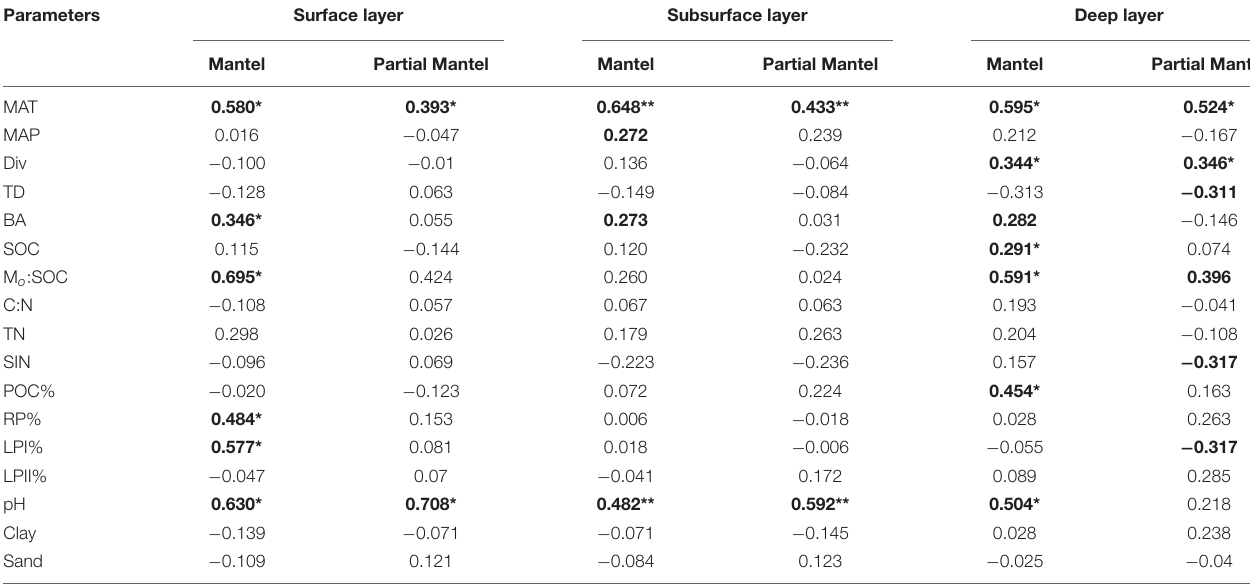
TABLE 3 | Mantel and partial Mantel tests of soil bacterial β -diversity with environmental parameters.